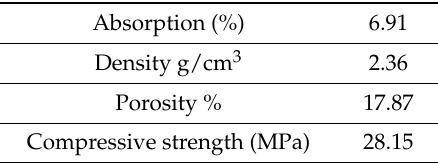
Table 1. Physical properties of old concrete.